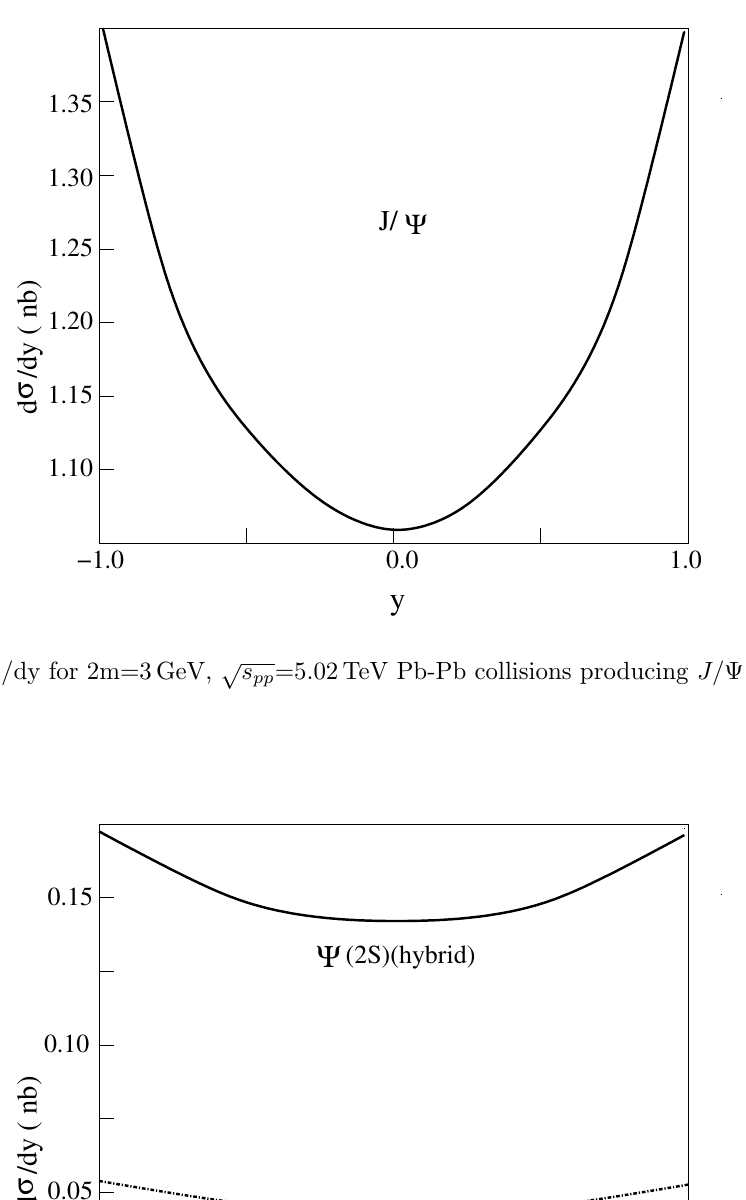
p Figure 2 . d (cid:27) /dy for 2m=3 GeV, s pp =5.02 TeV Pb-Pb collisions producing (cid:9)(2 S ), hybrid theory, with (cid:21) = 0. The dashed curve is for the standard c (cid:22) c model.